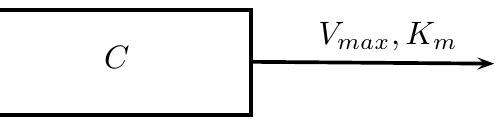
Figure 1. Scheme of I.V. bolus injection with Michaelis-Menten